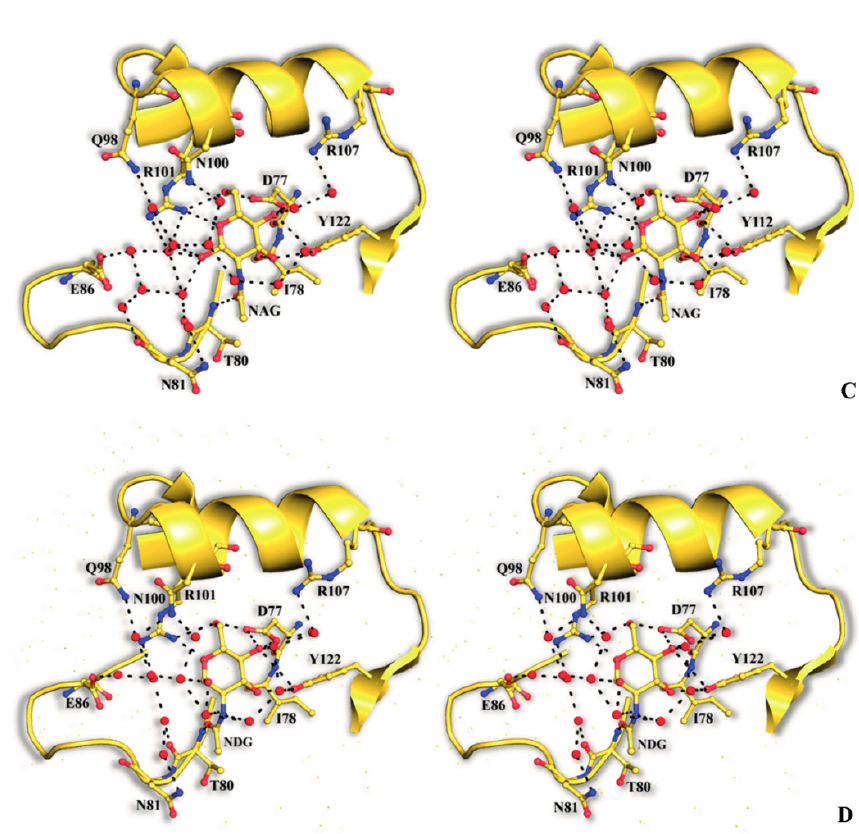
Figure 4. Stereoview of the carbohydrate interactions with the residues of SRL variants. SSR1 with N -acetyl β - D -glucosamine ( A ) and N -acetyl α - D -glucosamine ( B ); SSR2 with N -acetyl β - D -glucosamine ( C ) and N -acetyl α - D -glucosamine ( D ). The side-chains of protein residues are shown as ball-and-stick models. Bound water molecules are shown as blue spheres. Hydrogen bond interactions are represented by broken